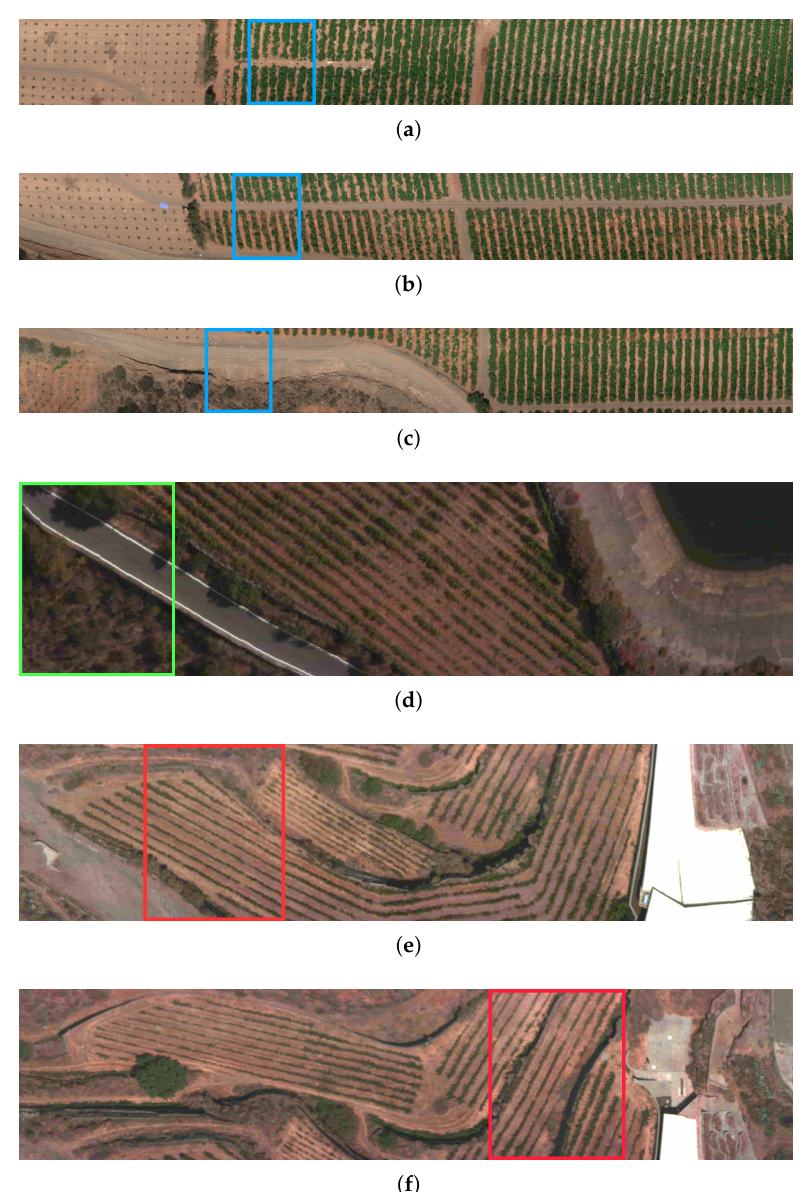
Figure 4. RGB representation of the hyperspectral data acquired in each mission campaign swath that was used in this work. Color squares highlight the regions selected for the experiments. ( a ) Image 1; ( b ) Image 2; ( c ) Image 3; ( d ) Image 4; ( e ) Image 5; ( f ) Image